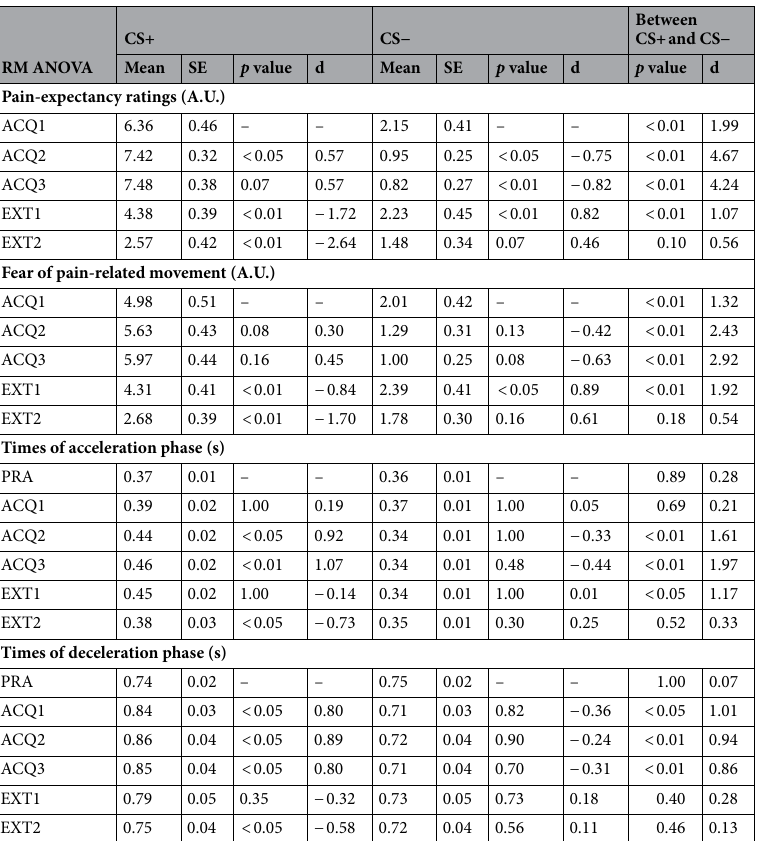
Table 1. Summary data and post hoc analysis of the RM-ANOVA. The post hoc analyses of the RM-ANOVA in each CS+ and CS− were used between the second and third blocks of acquisition periods and the first block of the acquisition period in pain-expectancy rating and fear of pain-related movement, and between the acquisition periods and the practice period in times of acceleration phase and times of deceleration phase, and between the extinction periods and the third block of the acquisition period in each variable. The post hoc analyses of the RM-ANOVA also were used between CS+ and CS− . Mean: Mean value. SE: Standard error. p < 0.05: Statistically significant after Holm-Bonferroni correction. d: effect size of post hoc analysis. PRC: practice phase. ACQ1–3: 1st, 2nd, and 3rd blocks of the acquisition phase. EXT1–2: 1st and 2nd blocks of the extinction